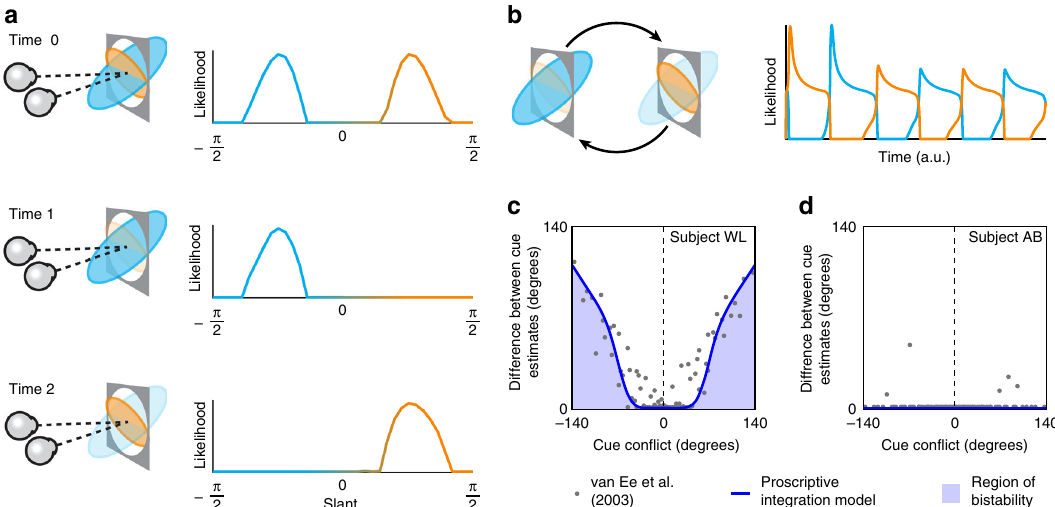
Fig. 6 Simulating perceptual rivalry with the proscriptive integration model. a Perceptual rivalry produced with the model: time 0 indicates the likelihood function represented in the output layer when two incongruent cues of equal reliability are simulated. Mutual inhibition between neuronal representations (and internal noise) results in dominance at time 1. Adaptation of the units representing the dominant representation results in its gradual decay and subsequent re-emergence of the non-dominant representation at time 2. b Likelihood of the simulated slant angles as a function of time, showing the typical dynamics of perceptual alternation. c Psychophysical data extracted from van Ee et al. 23 . This shows the difference between cue estimates as a function of cue con fl ict (see Online Methods for detailed description of data extraction and reanalysis). The blue line is a fi t of the proscriptive model and the shaded area indicates the experience of perceptual rivalry. d Depicts an example subject from van Ee et al. 23 in which one cue dominates perception and rivalry is not experienced. The blue line (barely visible) shows the fi t of the proscriptive model where the two cues are ascribed very different reliabilites such that one completely dominates the